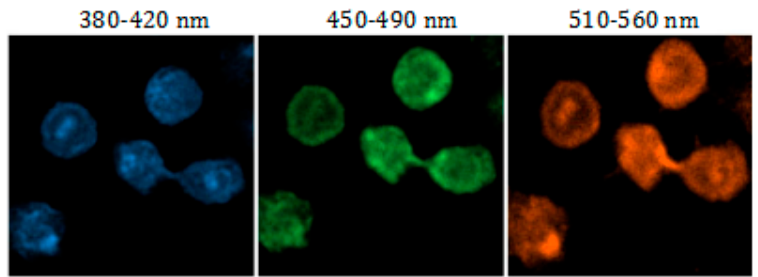
Figure 6. Laser confocal image of living Hela cells with multicolor cell imaging of interphase.